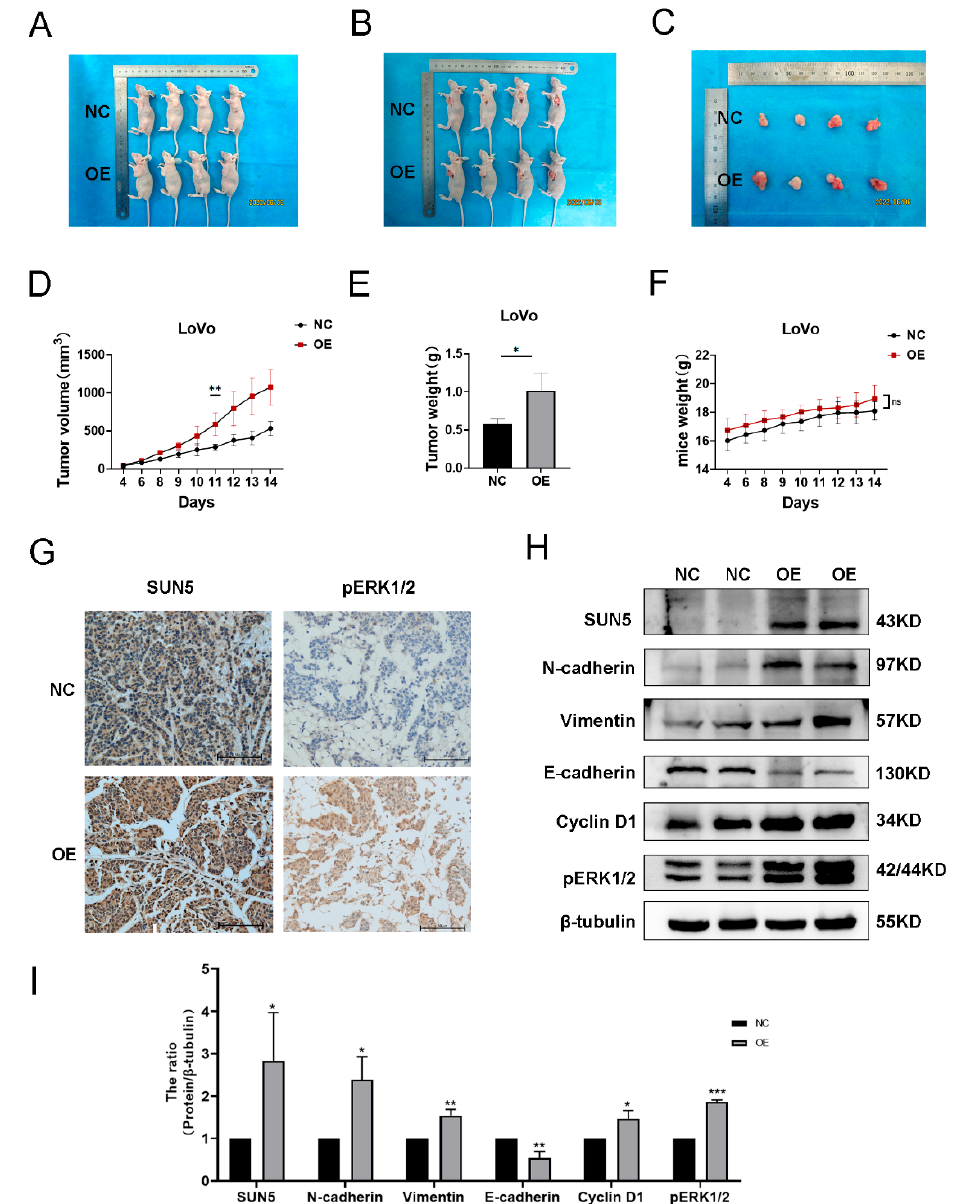
Figure 6. SUN5 overexpression accelerated the tumorigenicity of LoVo cells in vivo. ( A ) The subcutaneous tumor in nude mice formed by LoVo cells transfected with control and SUN5-OE lentivirus ( n = 4 in each group). After two weeks, all the mice developed tumors at the injection site; whole-body imaging was performed for each nude mouse, and the representative pictures were recorded and presented. ( B ) Images of subcutaneous tumorigenic nude mice after skin cutting. ( C ) Images of CRC tumor xenografts from each mouse. ( D ) Tumor volumes were recorded and analyzed (** p < 0.01). ( E ) Tumor weights were evaluated (* p < 0.05). ( F ) Nude mice weights were recorded and analyzed. ( G ) IHC staining of tumor tissues verified that SUN5 and pERK1/2 signals were still significantly obvious in the SUN5-OE group at the examination time (two weeks after the xenograft). Scale bar: 50 µ m. ( H , I ) Western-blotting assay showed the expression of SUN5, pERK1/2, Cyclin D1, E-cadherin, N-cadherin, and vimentin in tumor xenografts (in which two tumor tissue samples were randomly selected from each group; * p < 0.05, ** p < 0.01, *** p <